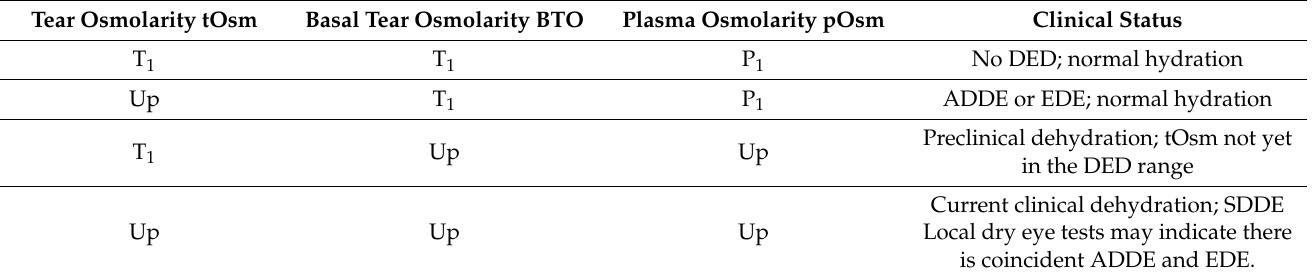
Table 2. Potential dry eye and hydration